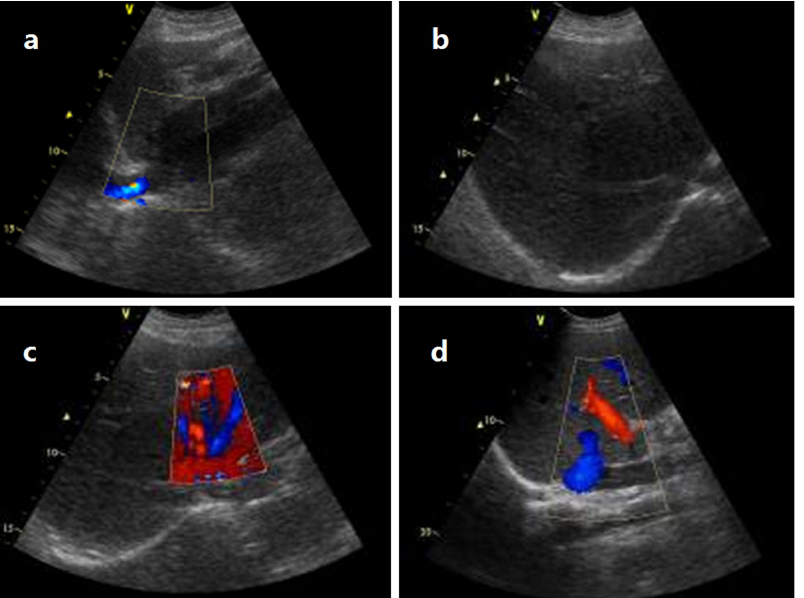
Figure 1. The preoperative color Doppler flow imaging. CDUS shows a membranous obstruction of IVC wiht thin beam-like flow (Figure 1 a), and the right HV is completely obstructed (Figure 1 b); There is a obliteration after the confluence of left HVs without blood flows (Figure 1 c), the right HV has compensatory enlargement, with blood flow draining into IVC (Figure 1 d).